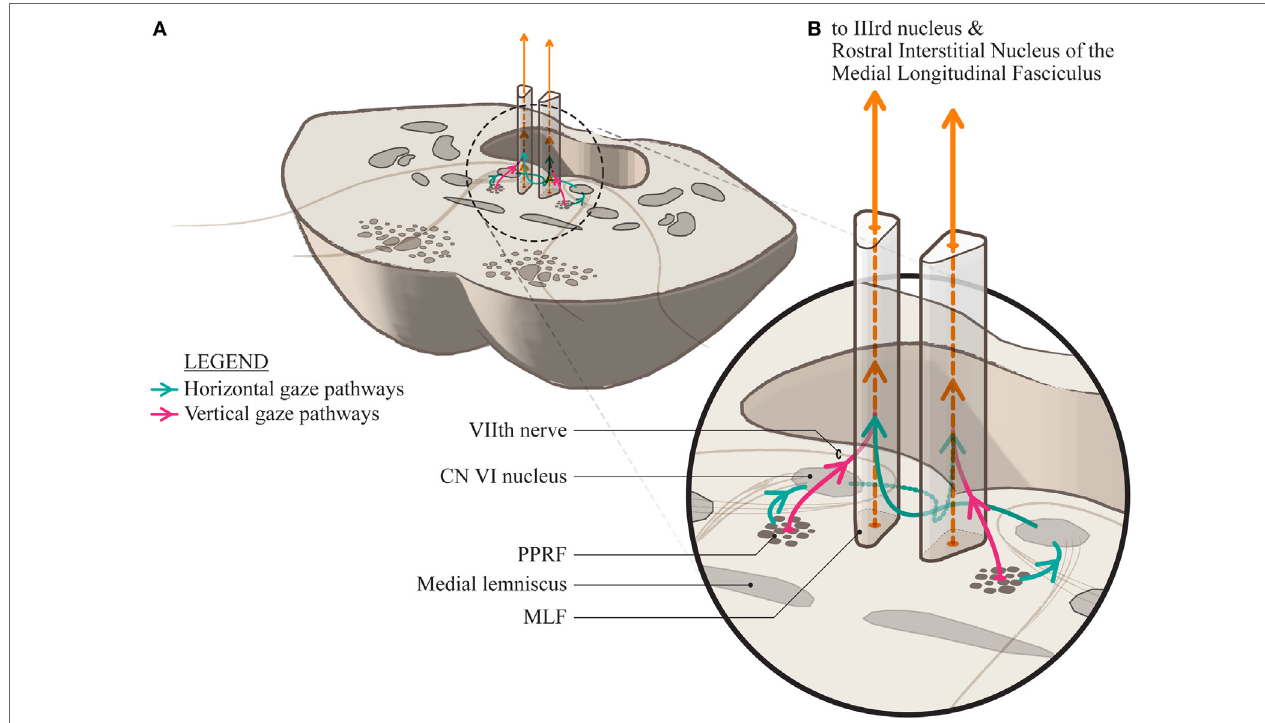
FIGURe 2 | (a) A section through the mid-pons showing the relationship of the paramedian pontine reticular formation to the median longitudinal fasciculus (MLF) and the adjacent seventh cranial nerve as it sweeps around the abducens nucleus. (B) A magnification showing the proposed conformation of the separate horizontal and vertical gaze paths as they project into the MLF. The horizontal signal decussates at the level of the pons and ascends in the contralateral MLF while it is uncertain whether the vertical gaze signal decussates at all, or is a direct